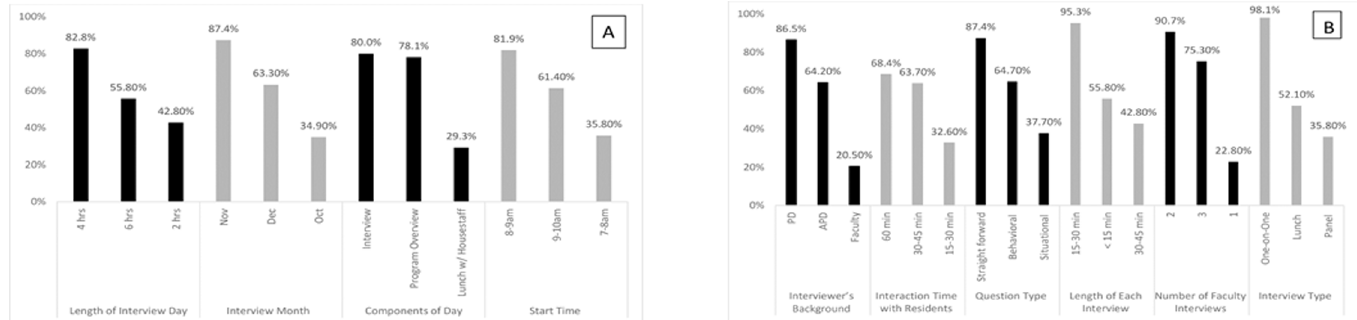
Fig 1. A-B: Percentages for Most Preferred Responses for Total Sample on ‘Optimal Interview Day Format’ Questions: (A) Structure of Day and (B) Interview Format .